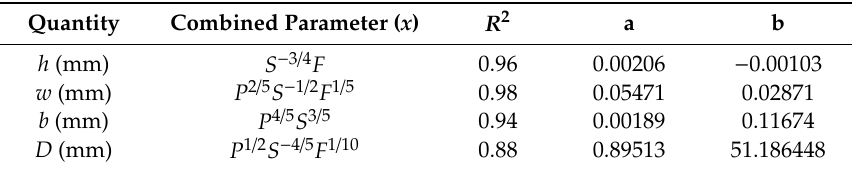
Table 2. Predicted combined parameters representing the best correlation with measured geometrical characteristics of single cladding.